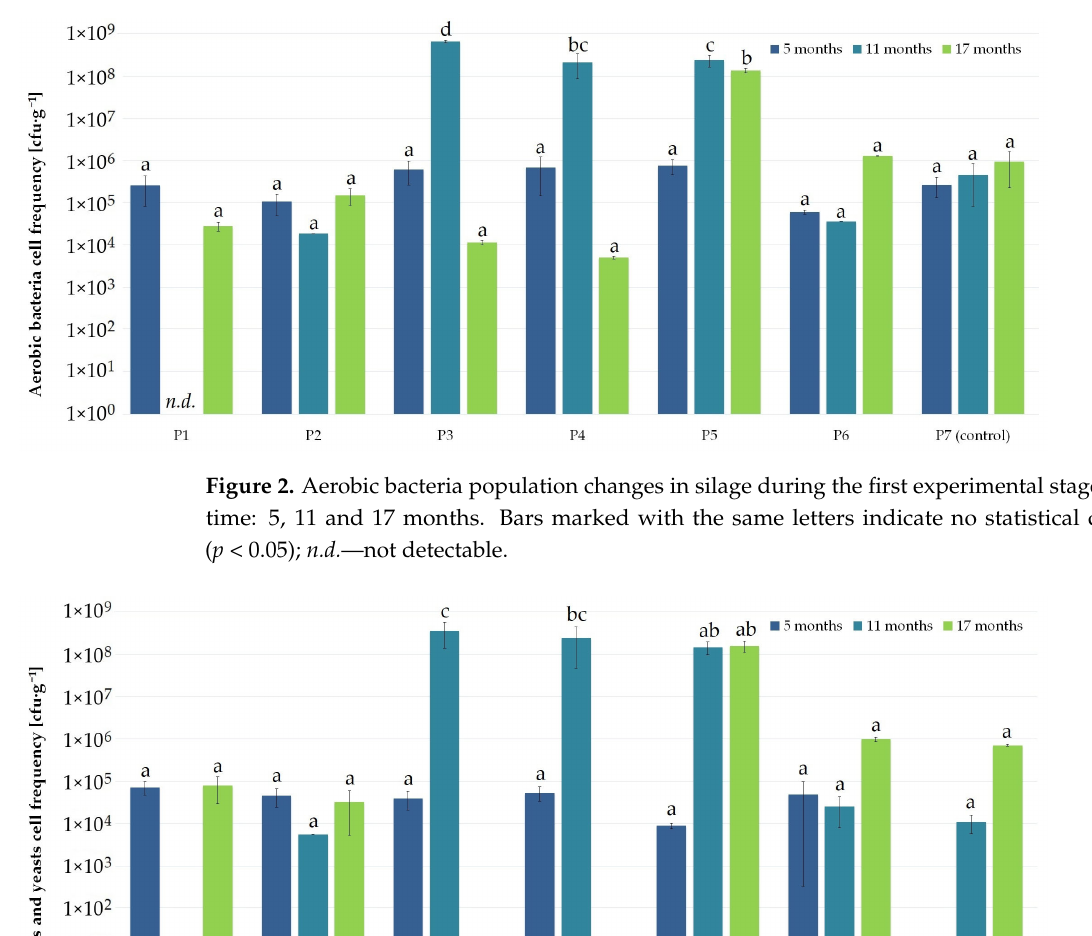
Figure 1. Lactic acid bacteria (LAB) population changes in silage during the first experimental stage. Storage time: 5, 11 and 17 months. Bars marked with the same letter indicate no statistical difference ( p < 0.05); n.d. —not detectable.